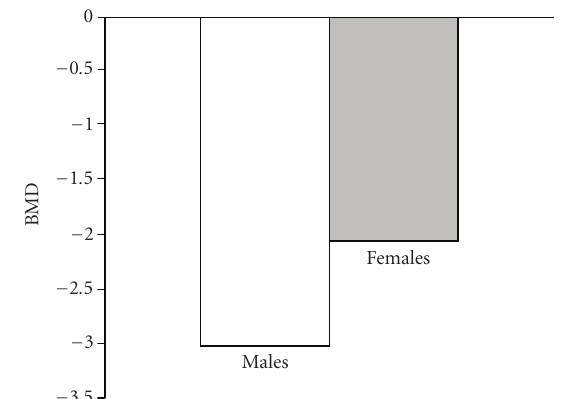
Figure 2: Mean BMD (spine) values in non-hypogonadal male and female patients with